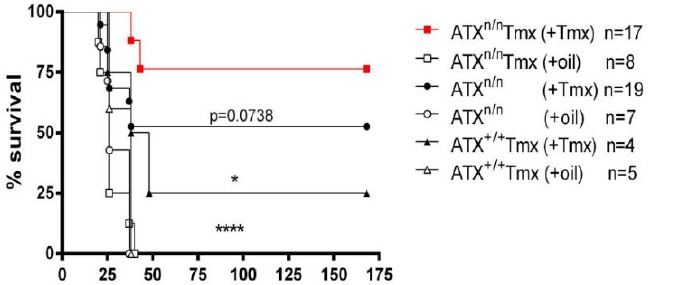
Figure 2. Increased survival rate upon the Tmx-induced genetic inactivation of ATX in mice. Kaplan – Meier survival curves of R26Cre-ERT2/Enpp2 n/n and control mice administered with Tmx. * denotes p < 0.05 and **** p < 0.0001.